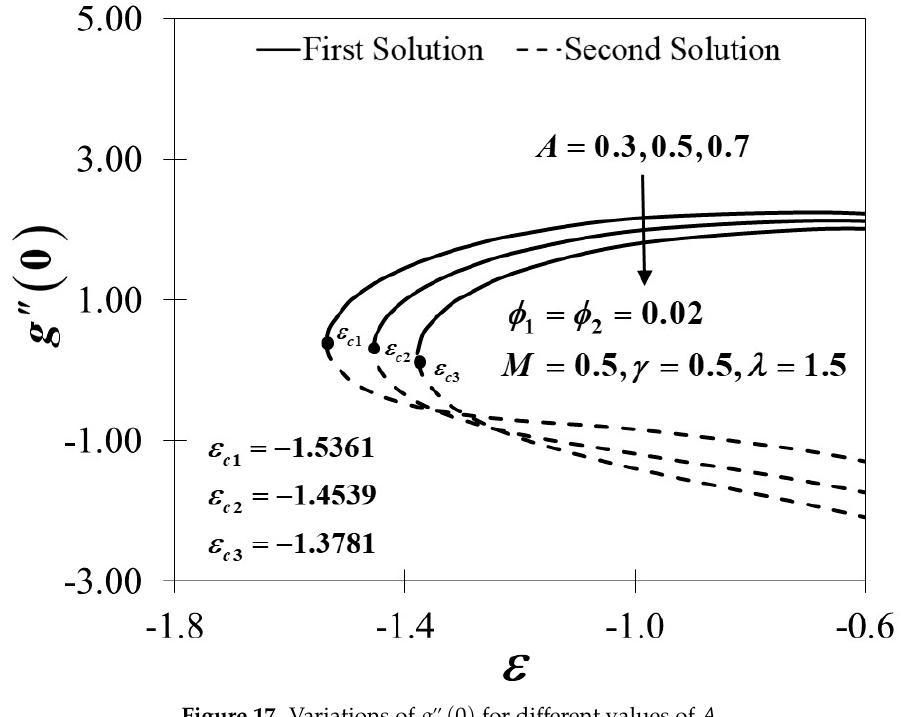
′′ for different values of A .